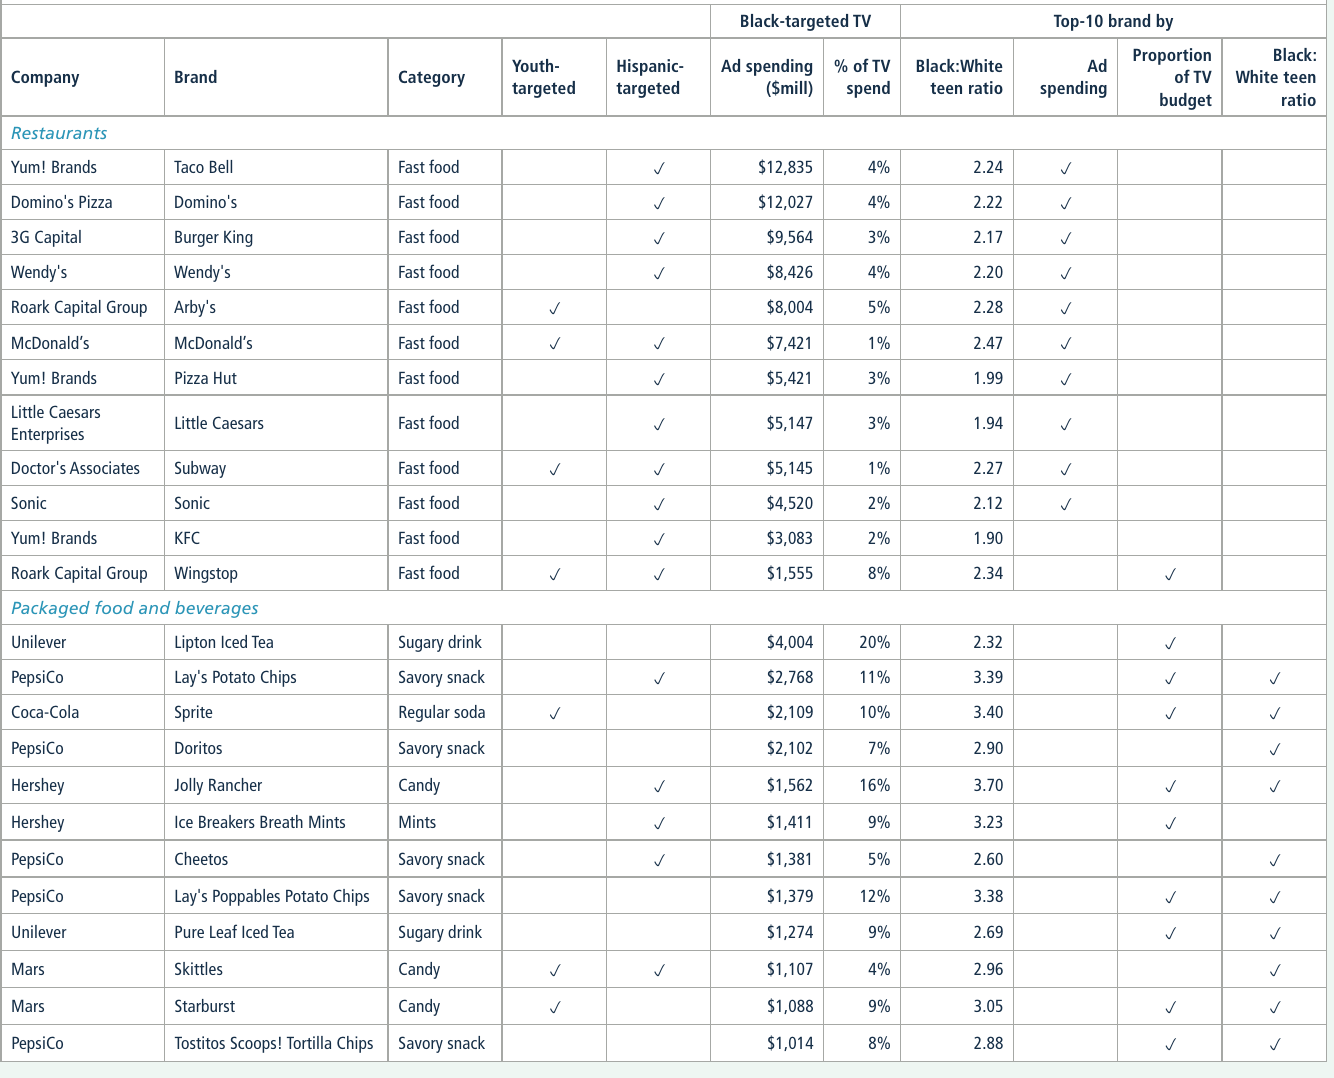
**Among brands spending $1.0 million or more in advertising on Black-targeted TV: Top-10 brands in spending on advertising on Black-targeted TV channels, proportion of TV advertising budgets allocated to Black-targeted TV, and/or greater relative exposure to TV ads by Black versus White teens (ages 12-17